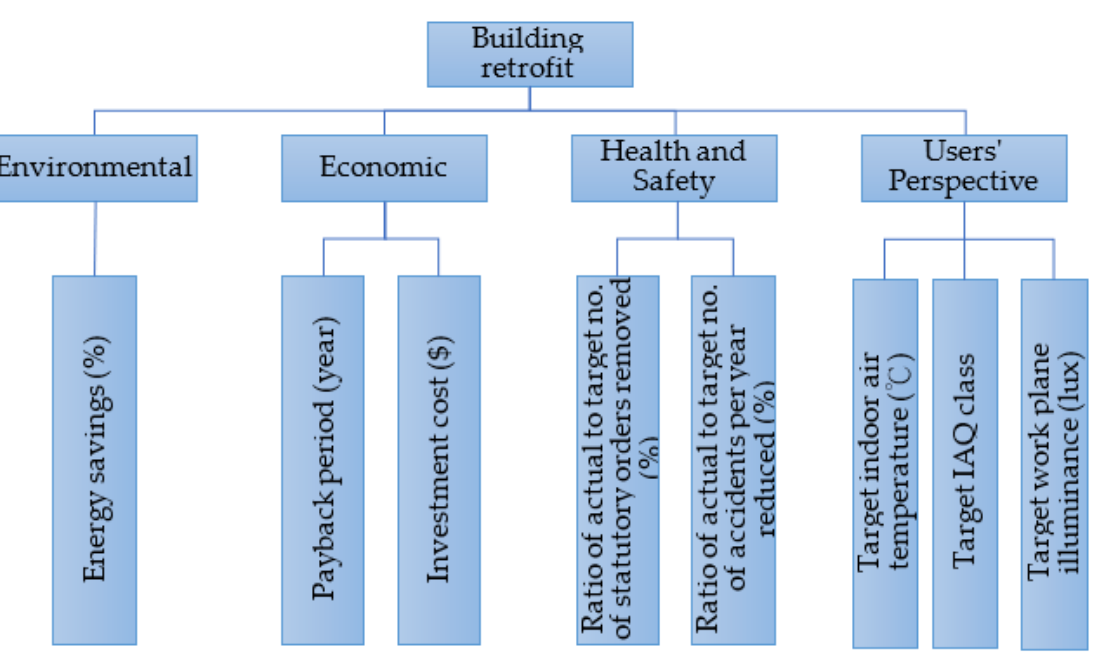
Figure 1. Building retrofit performance hierarchy.